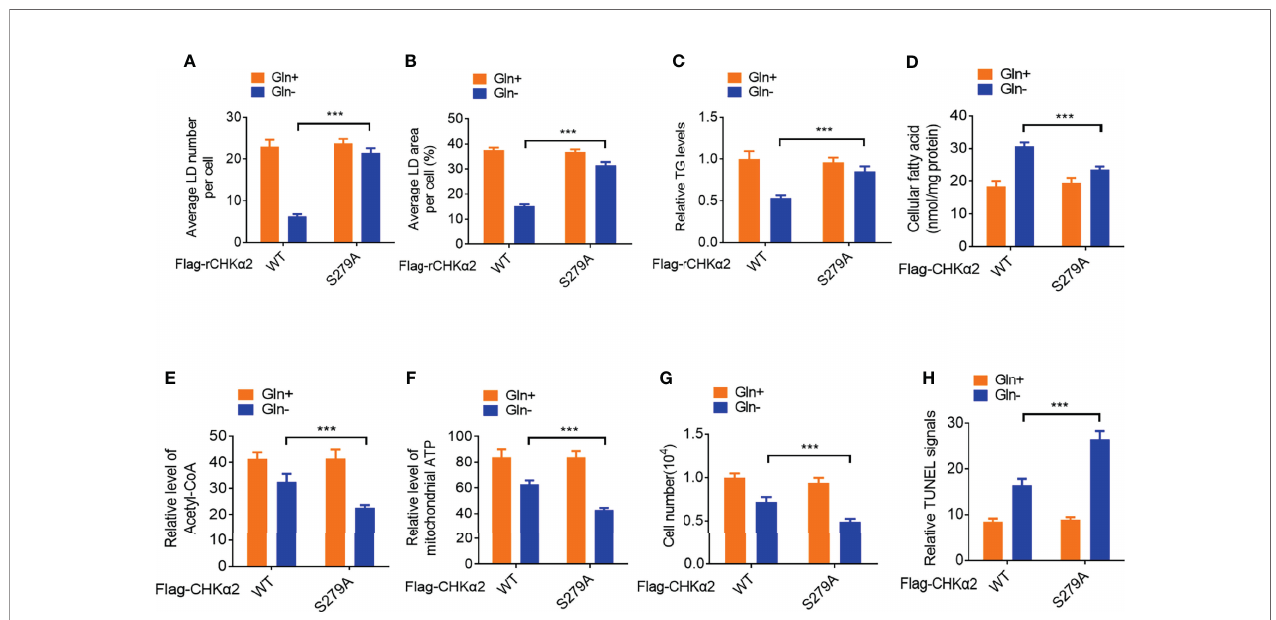
FIGURE 3 | CHK a 2 promotes lipid droplet lipolysis and survival of NSCLC cells. (A – C) Quantitative analyses of lipid droplet numbers, areas and relative TG levels in the endogenous CHK a 2-depleted H322 cells expressing Flag-rCHK a 2 WT or S279A were performed. (D – F) Cellular fatty acids and levels of mitochondrial acetyl- CoA and ATP were measured in the endogenous CHK a 2-depleted H322 cells with Flag-rCHK a 2 WT or S279A expression. (G, H) Cell numbers were counted, and TUNEL analyses were performed to measure cell death in the endogenous CHK a 2-depleted H322 cells with Flag-rCHK a 2 WT or S279A expression. ***P < 0.001.